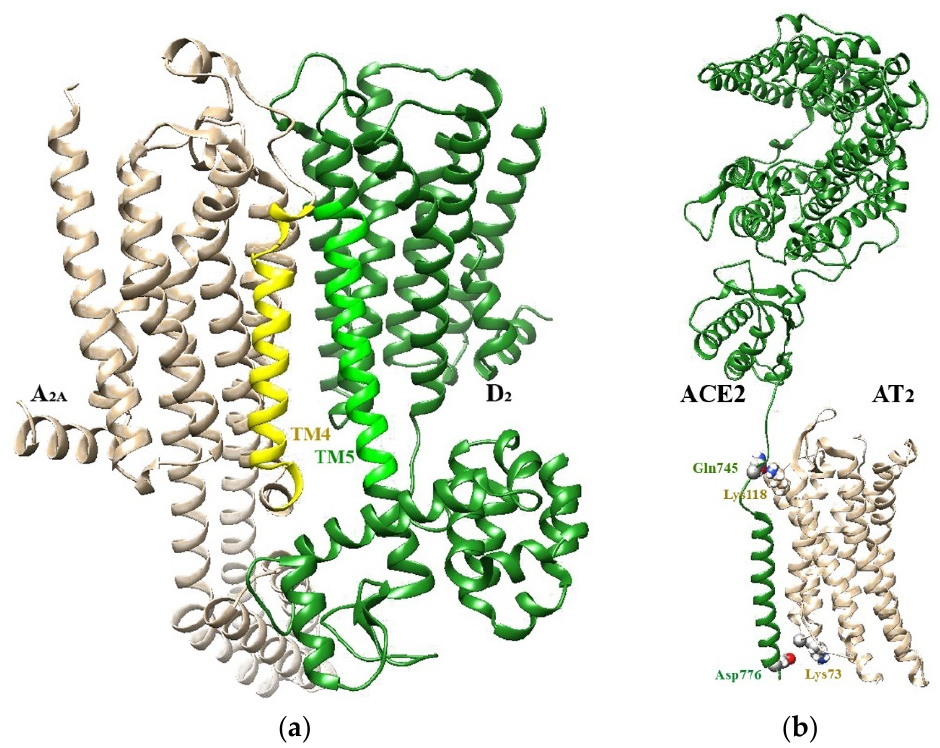
Figure 1. Models of heterodimers as estimated by bioinformatics methods: ( a ) A 2A –D 2 receptor complex according to [64]. The transmembrane domains TM4 and TM5 involved in the heterodimerization interface are emphasized; ( b ) Heterodimer between ACE2 and angiotensin AT 2 receptors as predicted by docking and molecular dynamics methods [65]. Residues predicted to be involved in H-bonds between monomers are also indicated.